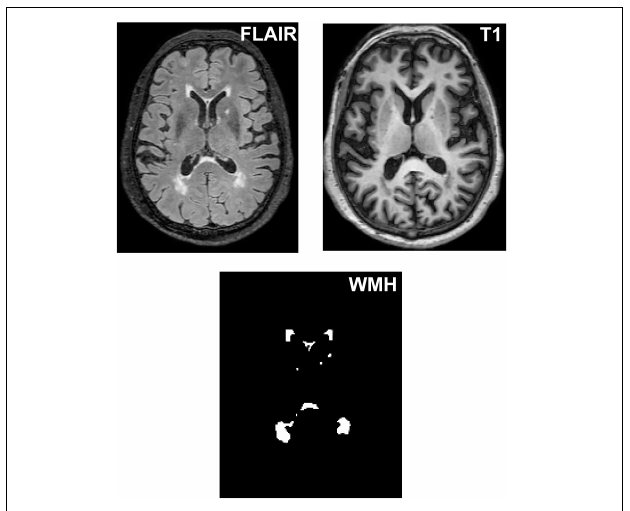
FIGURE 1 | The segmentation of WMH lesions. WMH lesions were segmented and quantified from T 2 FLAIR images and T 1 images.